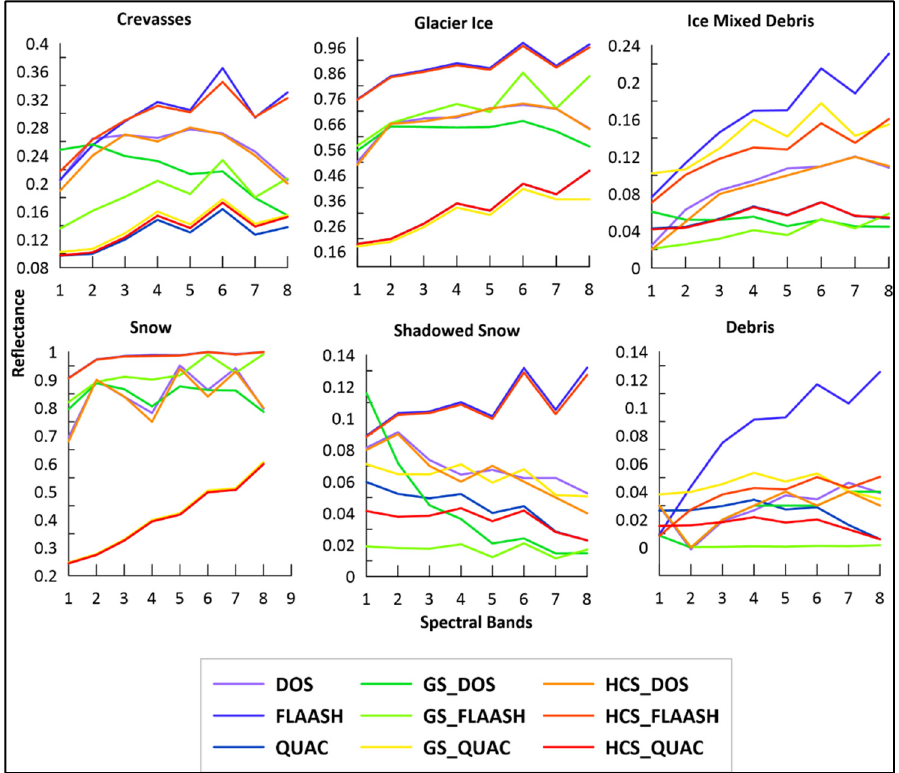
Figure 5. Variations in spectral signatures of identified facies in Chandra–Bhaga basin for each processing scheme. 1: Band 1/Coastal; 2: Band 2/Blue; 3: Band 3/Green; 4: Band 4/Yellow; 5: Band 5/Red; 6: Band 6/Red Edge; 7: Band 7/NIR 1; 8: Band 8/NIR 2.